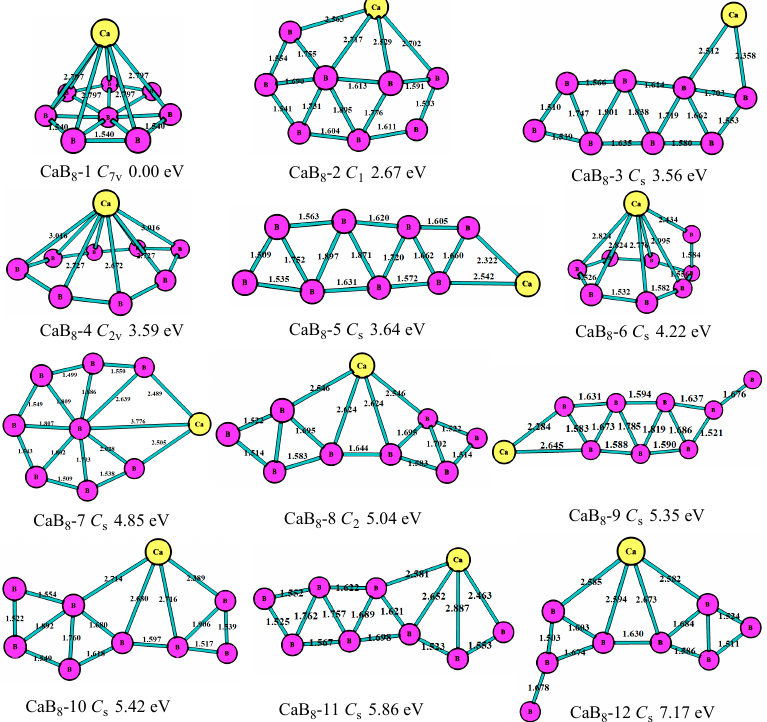
Figure 6. The geometry structures of the CaB 8 clusters obtained at MP2/6-311+G(d)//B3LYP/6-311+G(d). The bond length unit is Å.